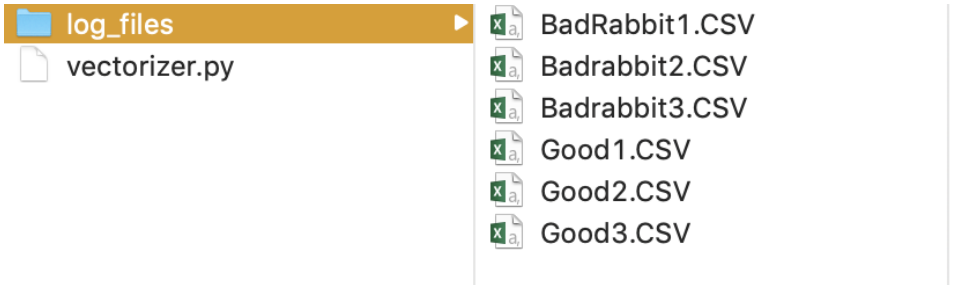
Figure 5. Log files for goodware and malware.